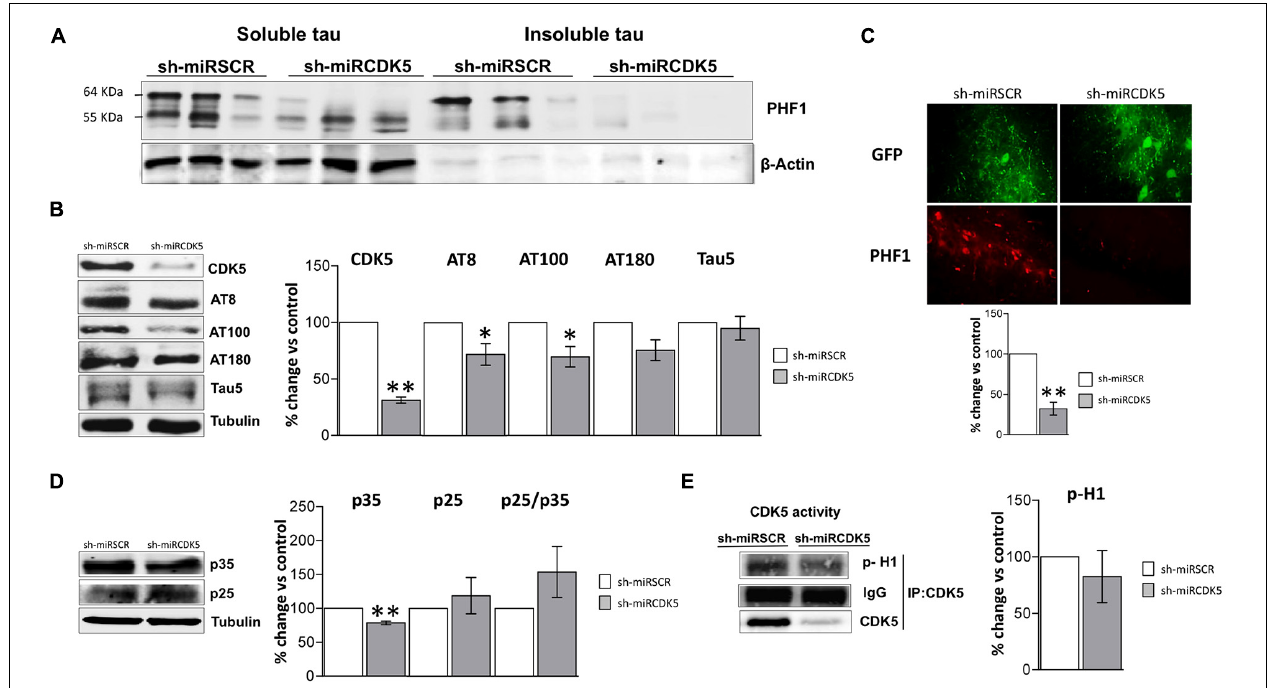
FIGURE 2 | Long-term therapy in 3xTg-AD mice with shCDK5miR can prevent accumulation of insoluble and hyperphosphorylated Tau. Long-term therapy prevented insolubleTau accumulation (64 kDa band) as measured by (A) sarkosyl-insoluble and solubleTau evaluated with PHF1 antibody, β -actin was used as loading control. (B) Likewise, long-term shCDK5miR maintained decreased CDK5 protein levels as well as reduced AT8 and AT100 in hippocampal lysates of 3xTg-AD mice. Representative blots are shown.Tubulin was used as loading control. Densitometry quantification was done. n = 3, * p < 0.05, ** p < 0.01. (C) PHF1 fluorescence intensity corroborated thatTau hyperphosphorylation diminished with long-term